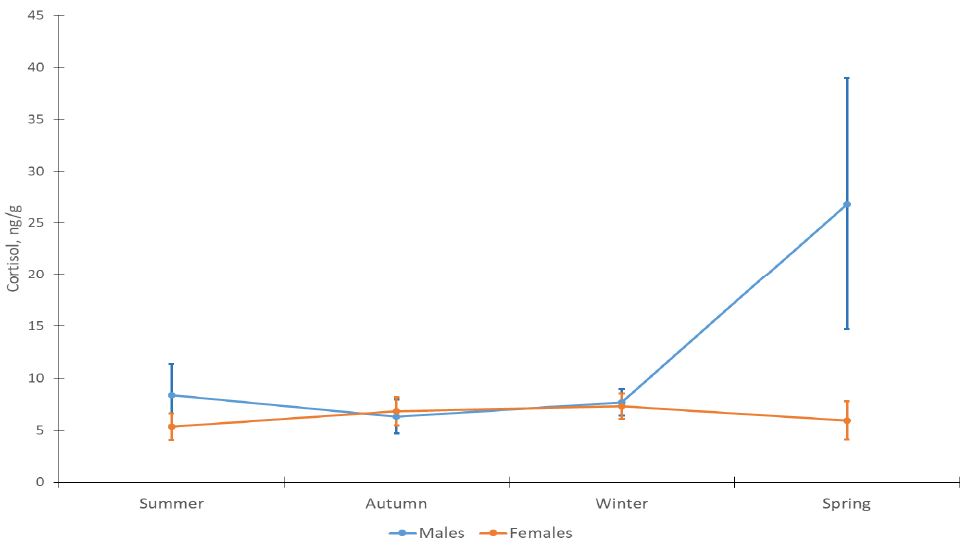
Figure 2. Cortisol concentration in hair of male and female domestic cats (males n = 5; females n = 12).